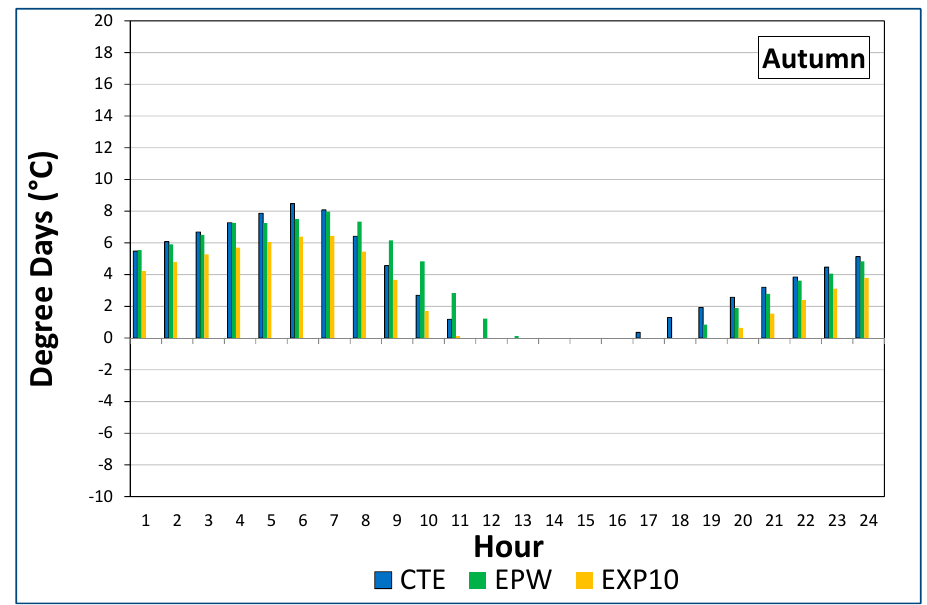
Figure 7. Hourly degree-days obtained in autumn obtained for three climate databases of Madrid: CTE, EPW and Exp10.